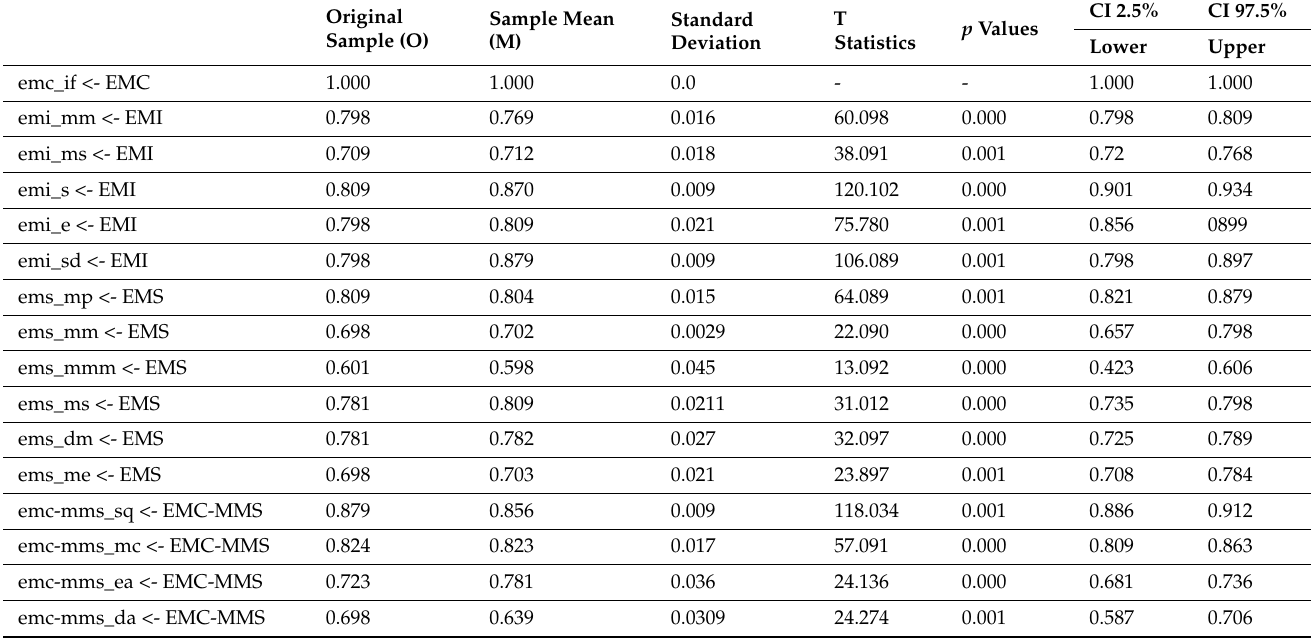
Table A4. Outer Loadings: mean, STDEV, T-Values, p -Values, confidence intervals.